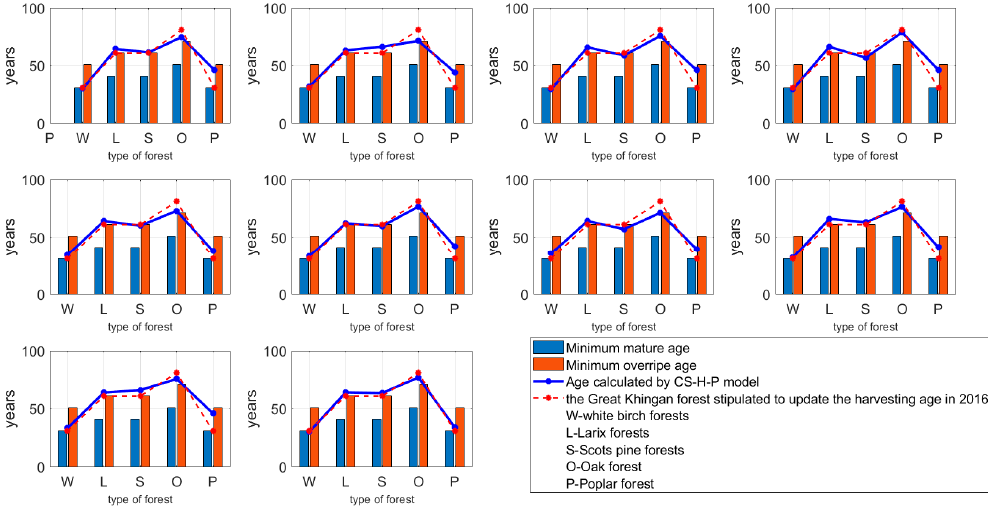
Figure 2. Analysis chart: The regeneration cutting age of planted forests.